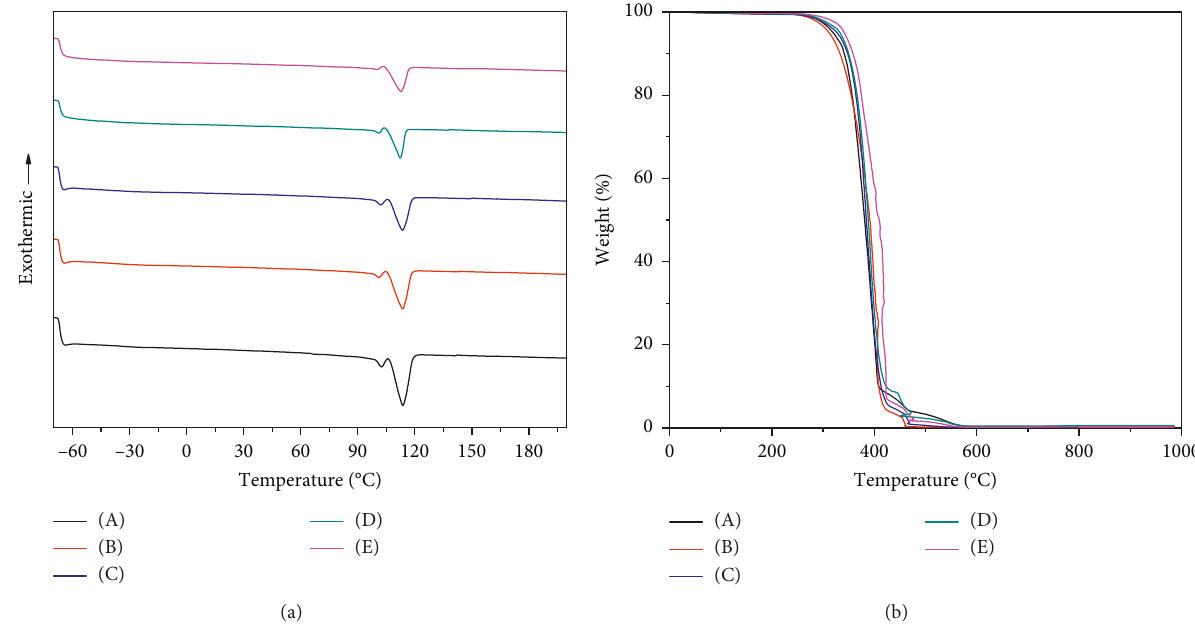
Figure 5: (a) DSC and (b) TGA thermograms of the pristine PBS and xCB-PBS composite materials. Note that the labels shown in the plots represent the materials as follows: (A) pristine PBS, (B) 3CB-PBS, (C) 5CB-PBS, (D) 10CB-PBS, and (E)